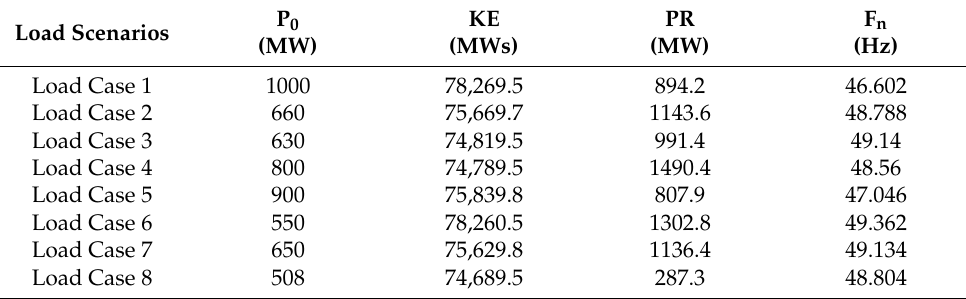
Table 3. Summary of P 0 , KE, PR and F n values for various load